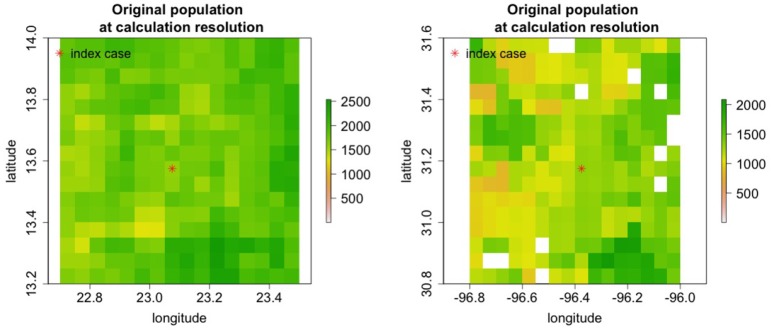
Cattle populations in two of nine regions where rinderpest introduction was simulated are shown in areas 0.8o longitude by 0.8o lattitide. For some simulations the area modeled was increased.